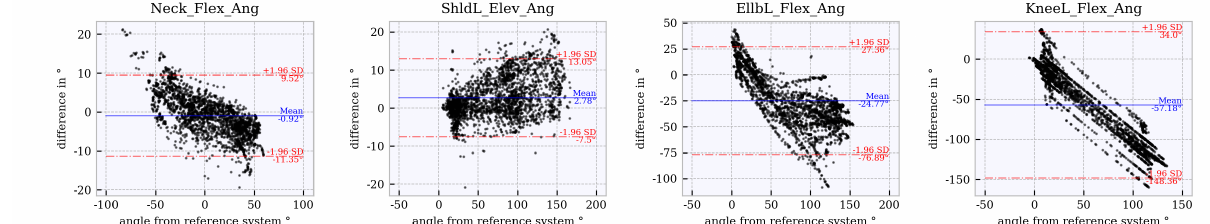
Figure 17. Bland–Altman plot for tracker configuration 3 from WIDAAN ; x does not show the average of both systems but the joint angles of the reference system, Qualisys.